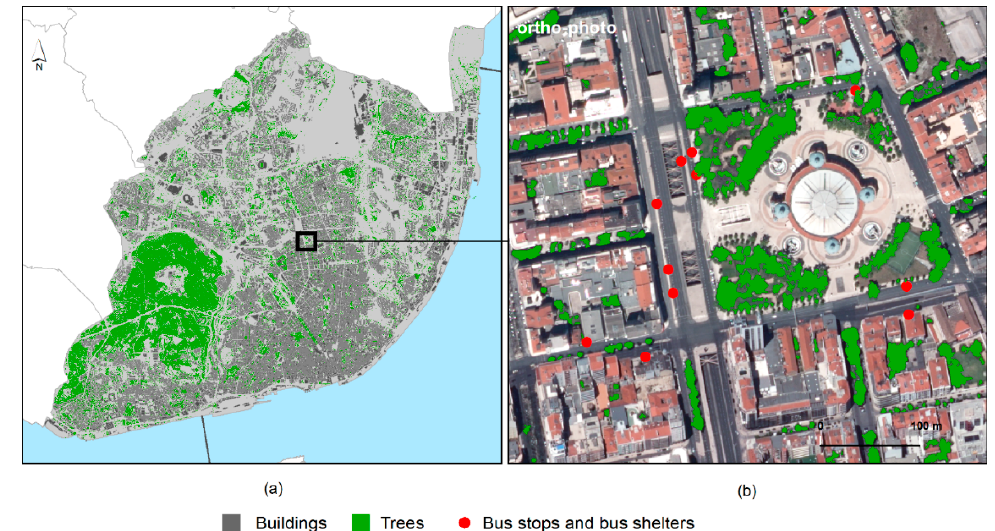
Figure 4. Tree map derived from the object-oriented classification of the ortho-photo for the whole city ( a ) and a neighborhood close-up ( b ) .